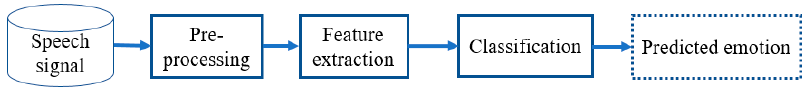
Figure 2. General speech emotion recognition system.